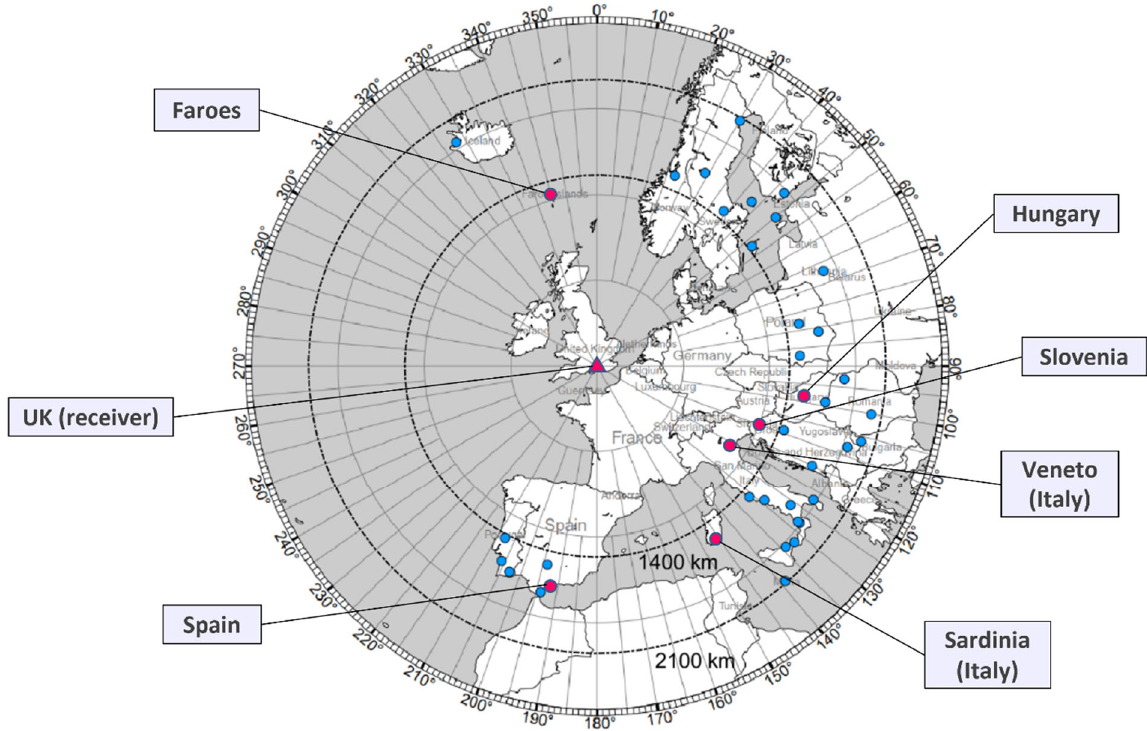
Figure 3. Azimuthal map centered on the receiving station, showing the locations of amateur 50 MHz beacon transmitters at distances between 1000 km and 2100 km. The red triangle marks the receiving station; red dots indicate the beacons included in the polarization measurement campaign; blue dots indicate other beacons. Note that in western Europe, magnetic North is within a few degrees of geographical North. © 2021 IEEE. Adapted, with permission, from [21].